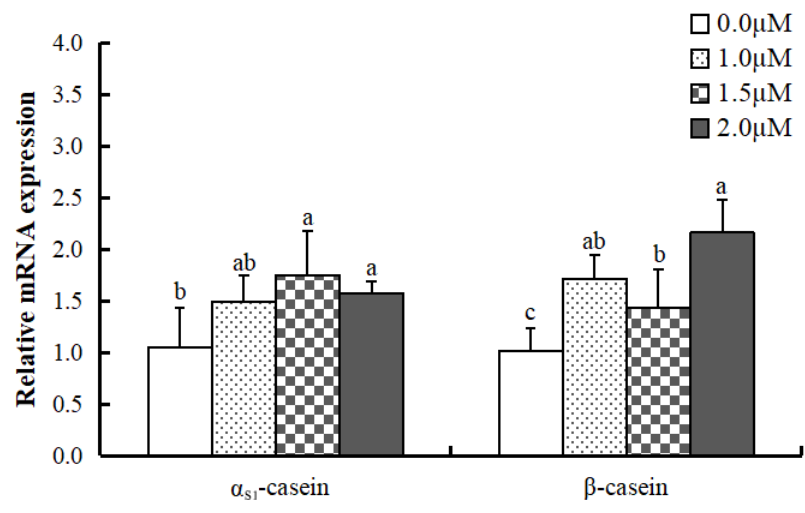
Figure 1. Casein mRNA expression levels in differentiated MAC-T cells treated with all-trans retinoic acid. Data are mean±standard deviation (n = 3). a-c mRNA levels of the same gene with different superscript letters are significantly different